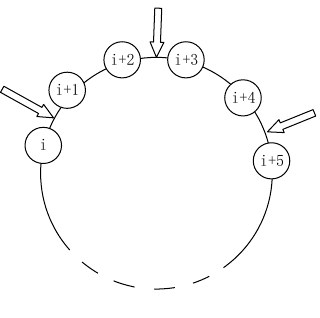
Figure 5. Attacking mode 3.